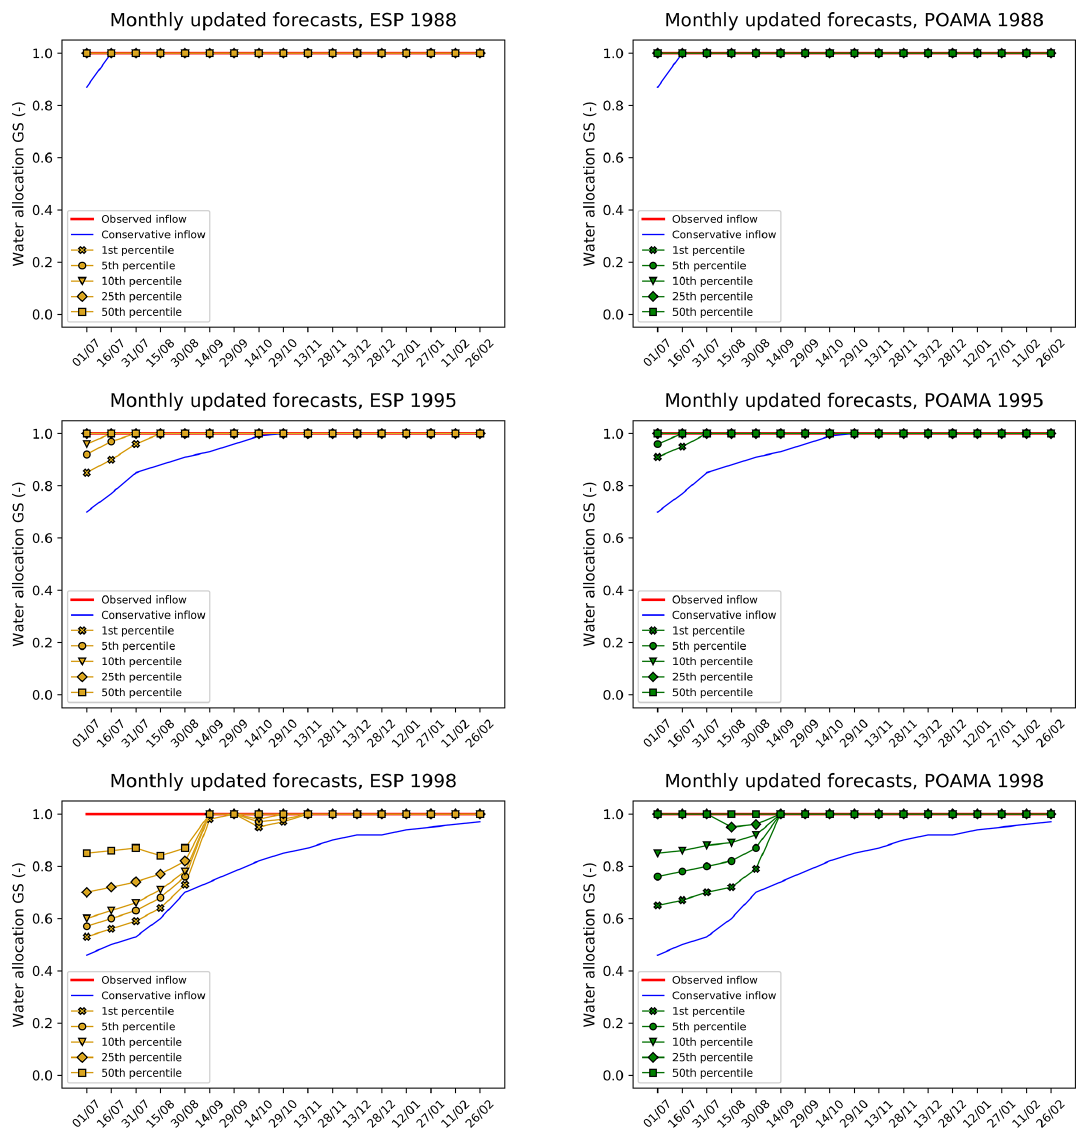
Figure 10. Water allocation GS for selected wet years (1988, 1995, and 1998) using new inflow predictions every month (monthly updated